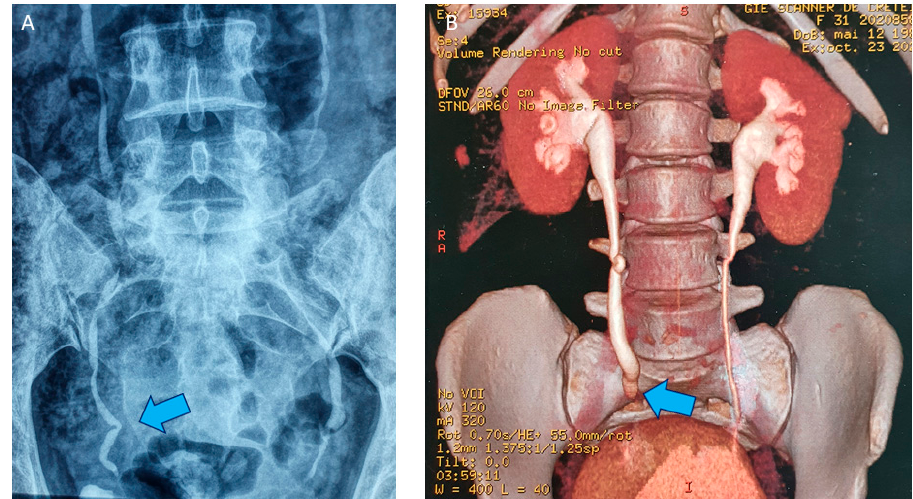
Figure 3. ( A ) Intravenous pyelography with attraction of the right ureter (blue arrow) due to the presence of a lateral DE nodule but without hydronephrosis. ( B ) 3D reconstruction after uroscanner with mild right hydronephrosis (blue arrow) due to a partially stenotic DE nodule.